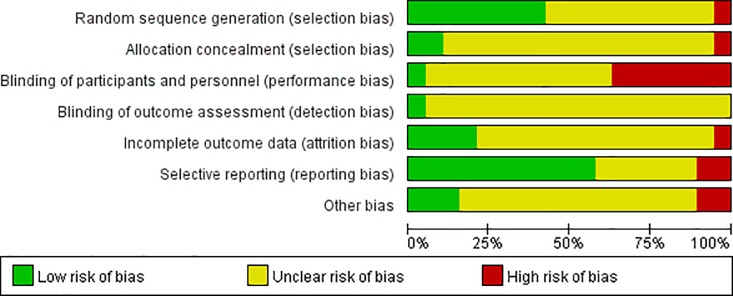
Risk of bias graph.